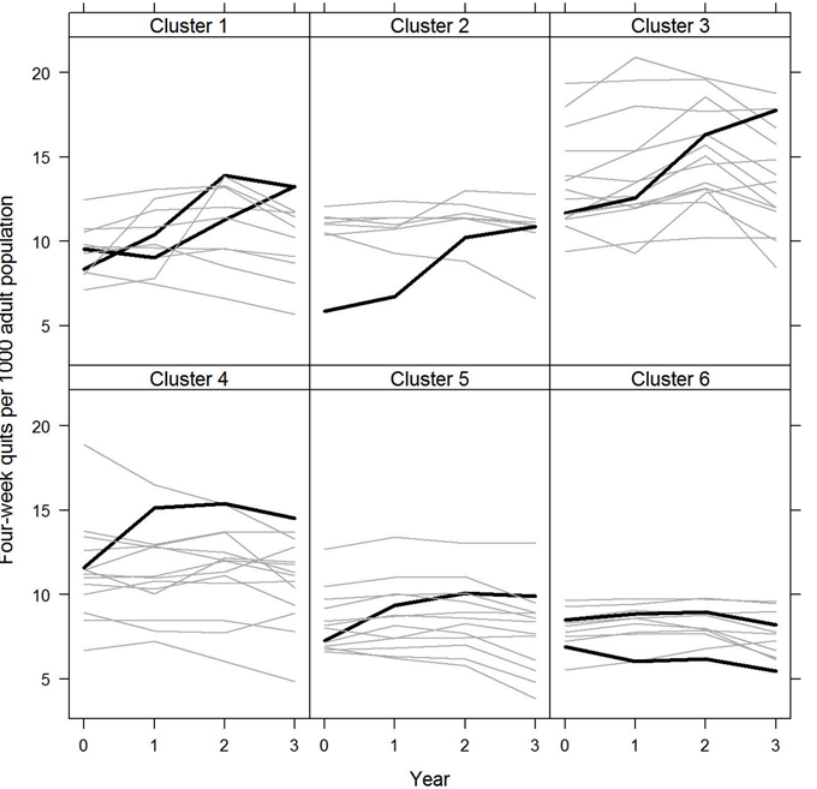
Fig 2. Enrolled smokers per 1,000 adult population for intervention and control PCTs by cluster: 2009/ 10 to 2012/13 The figure shows the change in this measure of quits over time for the intervention PCTs compared to their comparators in each of the six clusters. The clusters use the Office for National Statistics (ONS) subgroup categories for geographic areas of the UK based on similar local population characteristics. The eight intervention PCTs fall into six ONS subgroups along with 64 other PCTs which form the controls. Intervention PCTs are shown in black and control PCTs are shown in grey. 2009/10 = 0 and 2012/13 = 3.